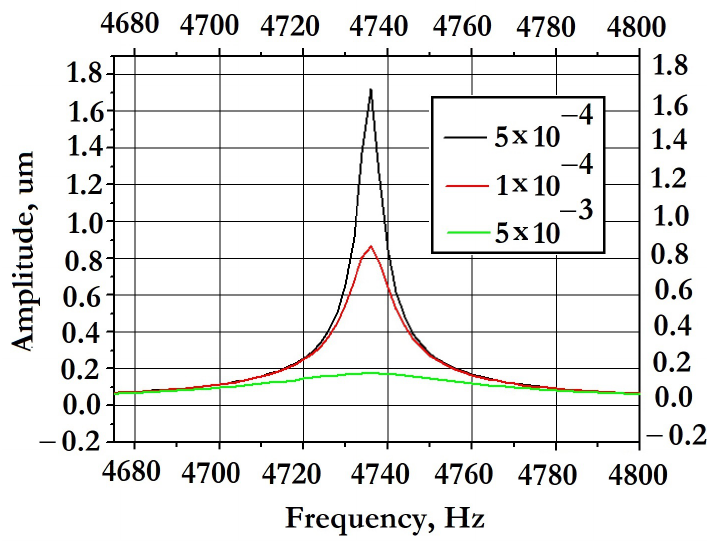
Figure 23. Calculated amplitude–frequency response of the DM with different damping.